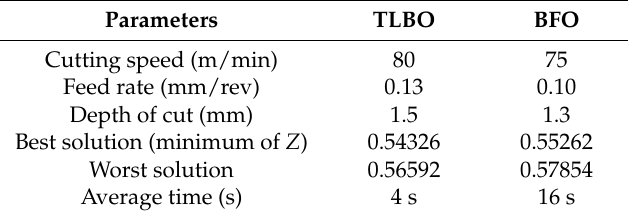
Table 3. Comparison of TLBO and BFO.